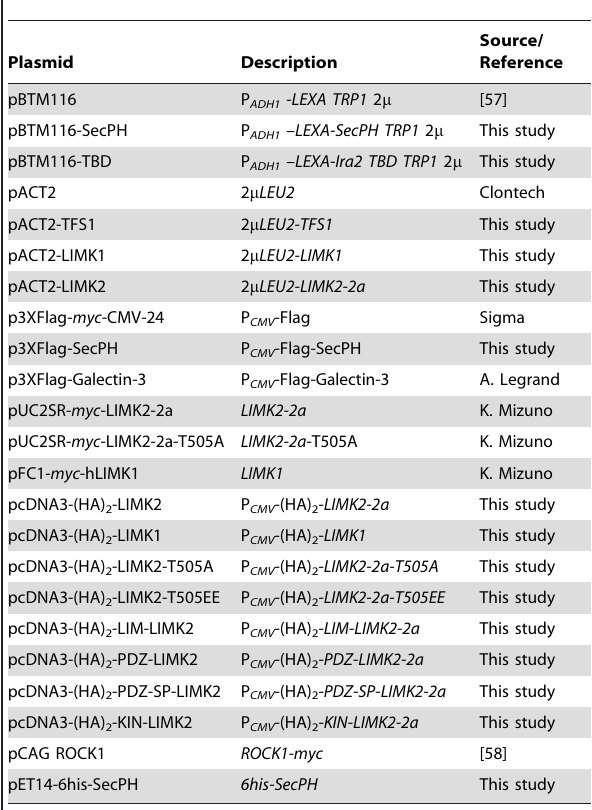
Table 1. List of plasmids used in this